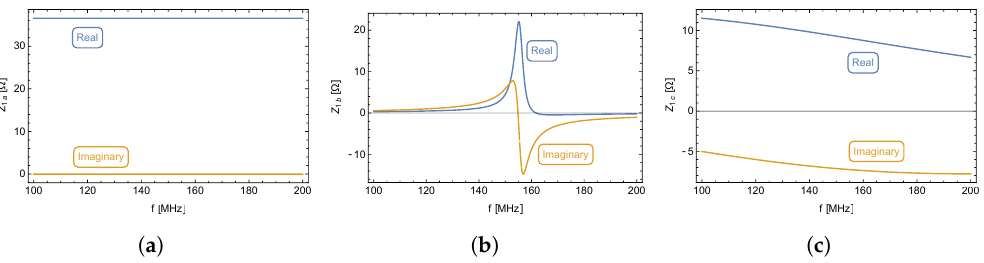
Figure 6. ( a ) First complex number of the Equation (5). ( b ) First and second fraction of the Equation (5). ( c ) Third and fourth fraction of the Equation (5).